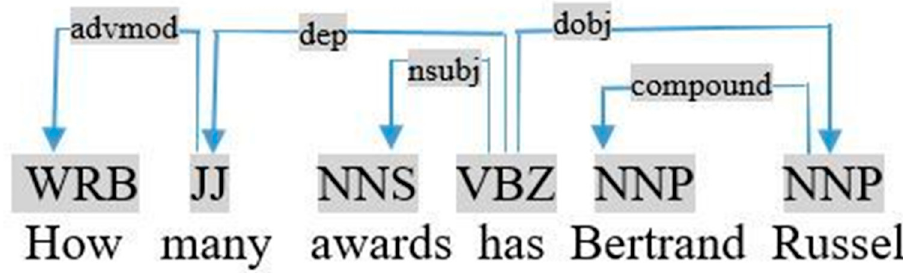
Figure 4. Graph dependency of the query «how many awards has Bertrand Russell».